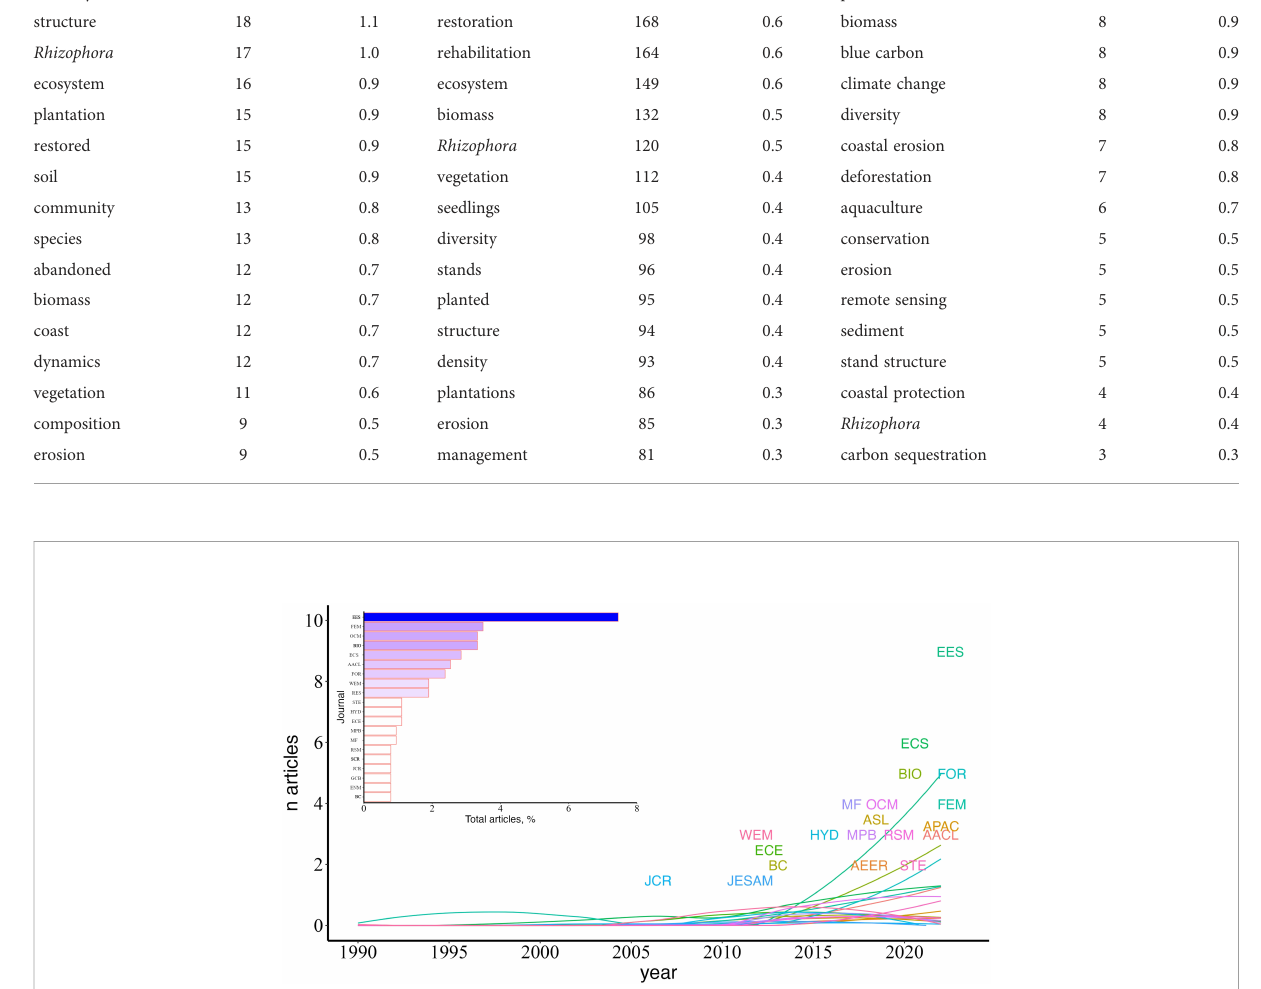
FIGURE 3 Most relevant sources that published mangrove restoration studies with ecological attributes from 1990-2022 (Inset: Most cited sources based on Total Citations). The names of the sources (journals) are placed in years when the highest number of manuscripts was published. Early restoration studies were limited to only fi ve journals but steadily increased after 2015 (> 10 journals). Complete names of sources ’ letter codes are available in Supplementary Table